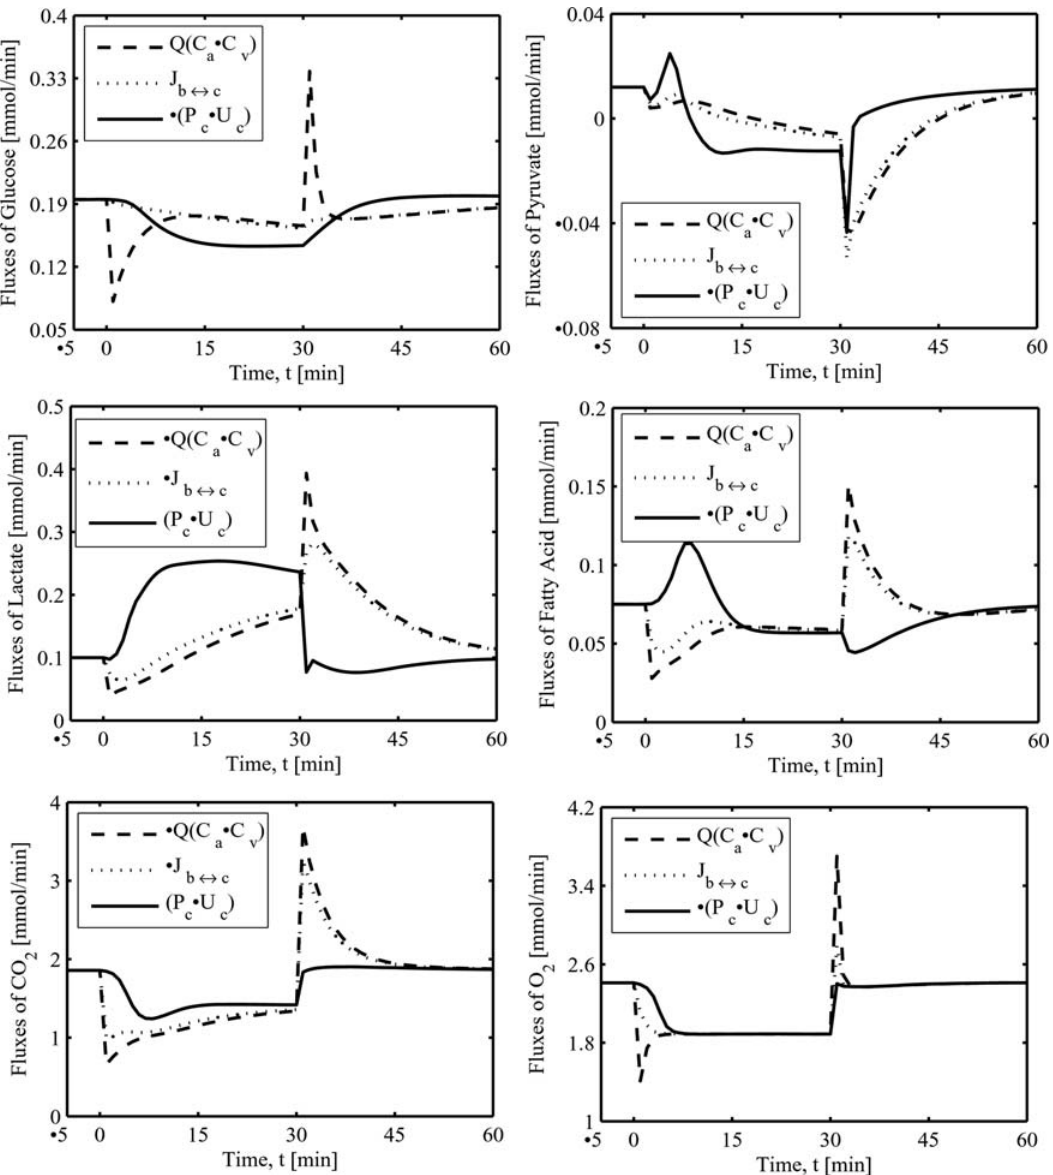
Figure 7. Model-predicted dynamic responses of transport and metabolic fluxes of glucose, pyruvate, lactate, free fatty acid, oxygen, and carbon dioxide during the resting, ischemia and recovery periods with a blood flow reduction of about 76%. The responses were computed using the estimated optimal parameter values with the ischemia protocol of 2 5 to 0 min of resting, 0 to 30 min of ischemia, and 30 to 60 min of recovery. The muscle blood flow Q is reduced as a step from 0.9 L/min at rest to Q isch =0.216 L/min at the onset of ischemia and returned to 0.9 L/min at the onset of recovery. Q(C a –C v ): uptake-release rates, J b « c : blood-tissue cells transport rates, P c –U c : tissue cells production-utilization